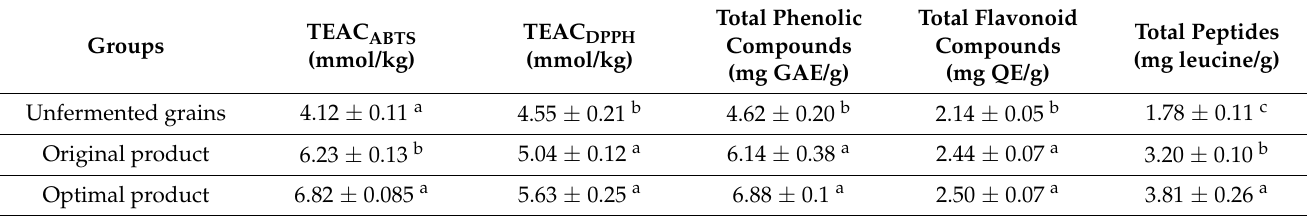
Table 3. Bioactive content of unfermented, fermented, and optimally fermented products.